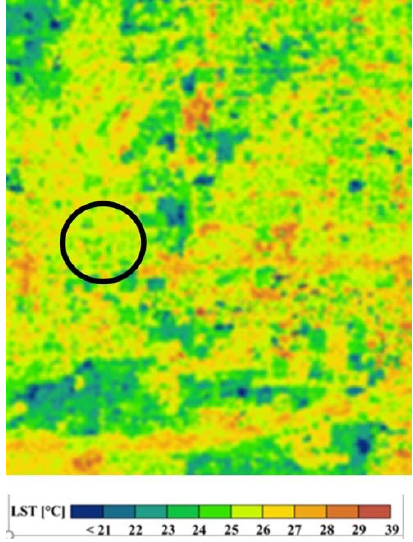
Figure 4. Surface temperature image at 10:30 p.m. on 31 May 2015. Study area is circled. Table 2. Nighttime surface temperatures.